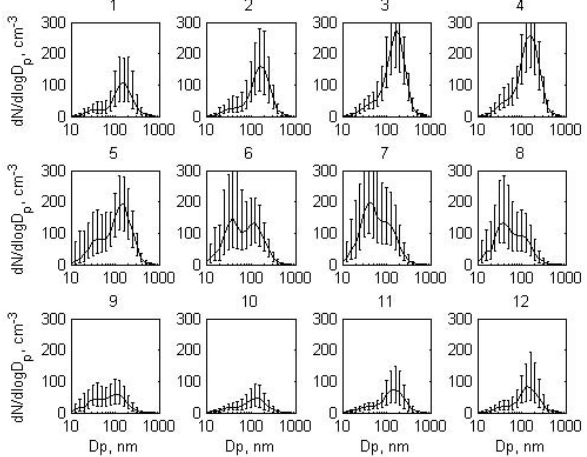
Fig. 7. Monthly median size distributions for the years of March 2000–March 2010. 25–75th percentile ranges indicated by error- bars. Corresponding lognormal-fitting parameters are shown in Ta- ble 2.